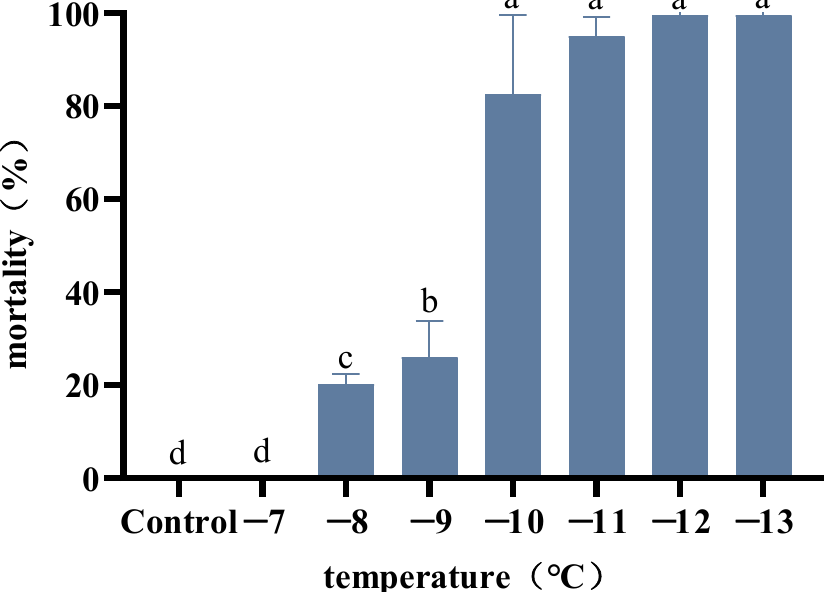
Figure 1. Mortality of the adult males and females of Agasicles hygrophila after exposure to identification temperatures for 2 h. Adults maintained at 26 °C served as untreated controls. Different letters refer significant differences in the mortality of beetles exposed to the different temperatures for 2 h (Tukey multiple comparison test at p < 0.05). Based on these results, we used exposure to a temperature of − 10 °C for 2 h as the identification temperature treatment. All values are presented as the mean ± SE.